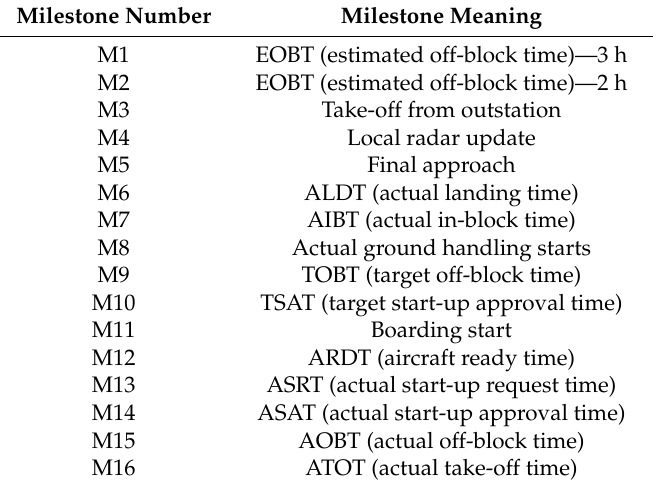
Table 2. Selected milestones along the flight process (A-CDM concept). Adapted from